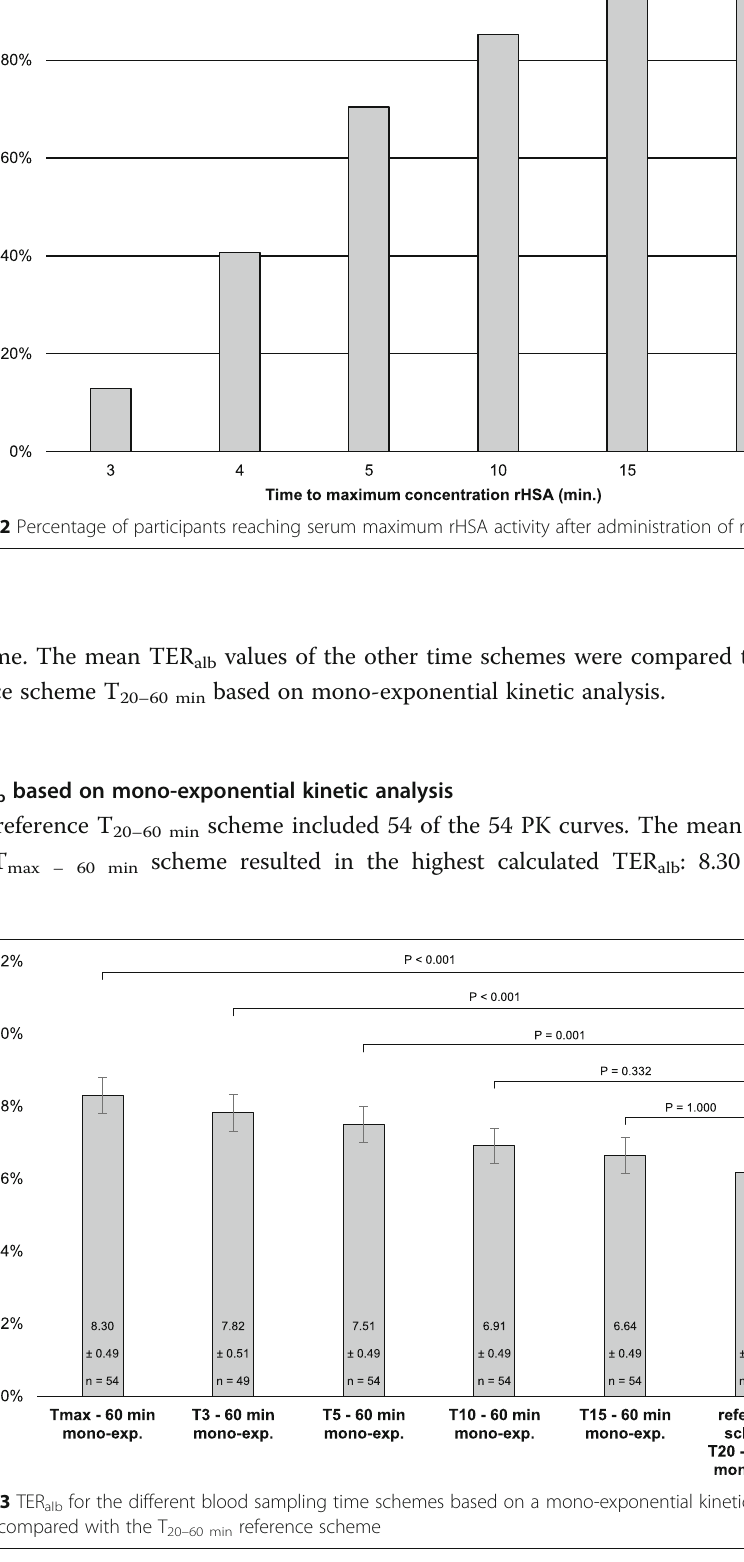
Fig. 3 TER alb for the different blood sampling time schemes based on a mono-exponential kinetic analysis and compared with the T 20 – 60 min reference